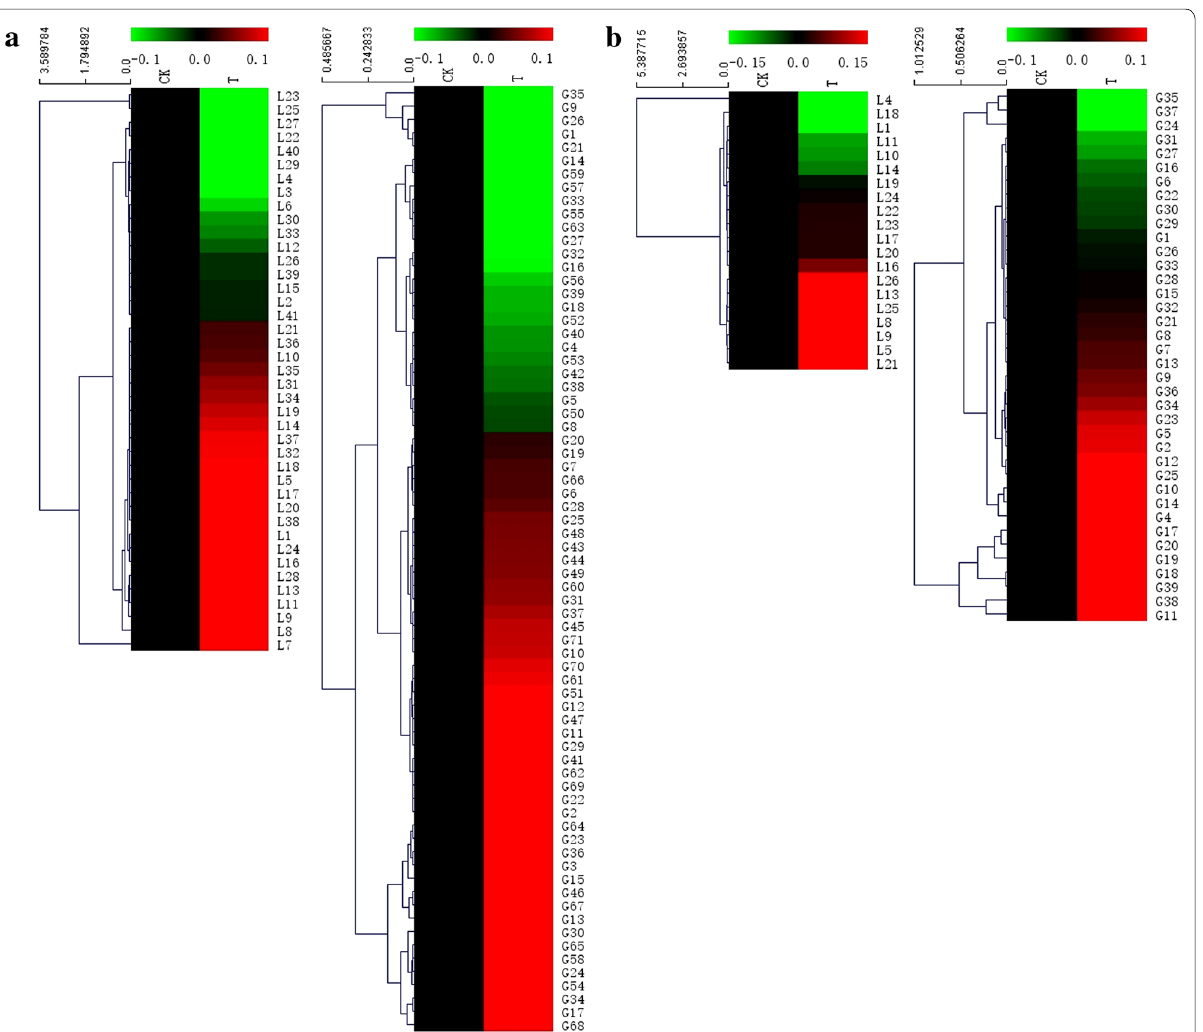
Fig. 6 Hierarchical clustering analysis of the DAP spots and phosphorylated proteins identified from flag leaves and developing grains. a Hierarchical clustering of all DAP spots from flag leaves and developing grains in protein level; b hierarchical clustering of phosphorylated proteins from flag leaves and developing grains in phosphorylation level. The upregulation and downregulation are indicated are indicated in red and green,